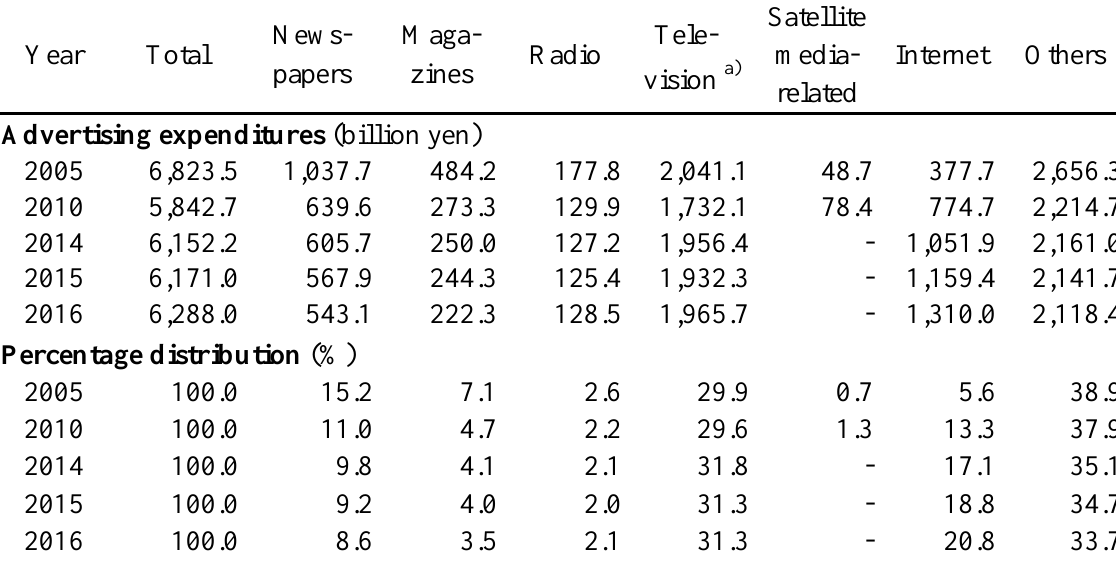
Advertising Expenditures by Medium News- Maga- Tele- papers zines vision a) Advertising expenditures (billion yen) 2005 6,823.5 2010 2014 2015 6,171.0 2016 6,288.0 Percentage distribution (%) 2005 100.0 2010 100.0 2014 100.0 2015 100.0 2016 100.0 a) Television including Satellite Media-Related advertising after 2013. Source: Dentsu